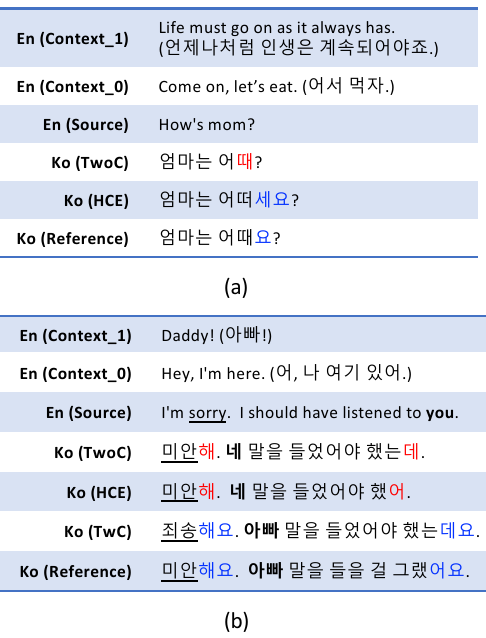
Figure 8. Example translations of different NMT models. The sentences are given in a sequence, from context_1 to source. The reference translation of each contextual sentence is given in (). In ( a ), a mother and her child are talking to each other. The context-aware model (HCE) can infer this situation using contextual sentences and translate the source sentence with an appropriate honorific style. Similarly, in ( b ) a dad and his child are talking, but only a translation from TwC has the correct honorific style. Note that translations of the verb sorry and the 2nd person pronoun you also differ among models despite that all the translations have the same meaning as the source